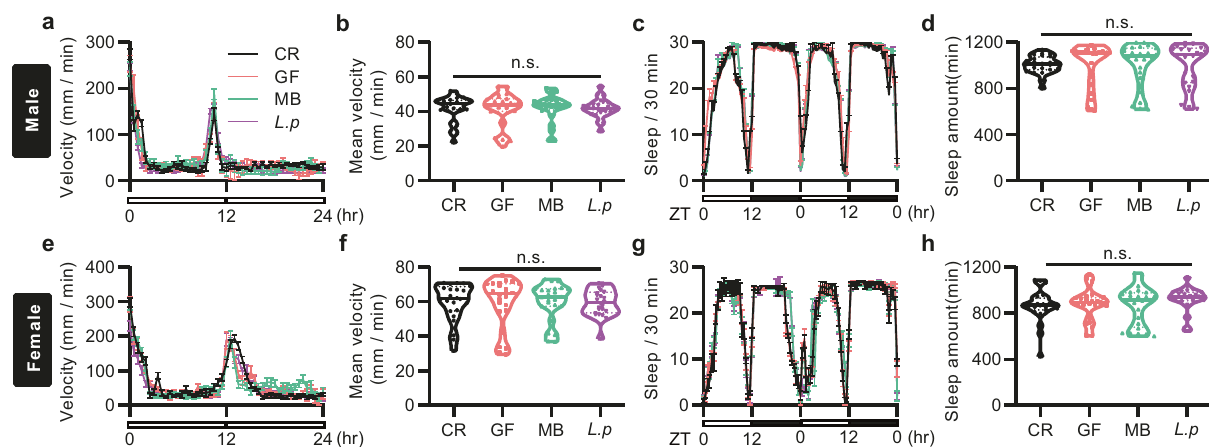
Fig. 2 Gut microbiome does not affect locomotor behaviors. a , b Drosophila 24-h walking speeds ( a ) and the average velocity ( b ) of GF males were not signi fi cantly different compared to CR, MB, and L.p counterparts. n = 24 for each. c , d GF males had largely unaltered sleep pro fi les ( c ) and total sleep amounts ( d ) in males compared to CR, MB, and L.p counterparts. n = 24 for each. e , f 24-h walking speeds ( e ) and the average velocity ( f ) of GF females were not signi fi cantly different compared to CR, MB, and L.p counterparts. n = 24 for each. g , h GF females had largely unaltered sleep pro fi les ( g ) and total sleep amounts ( h ) compared to CR, MB, and L.p counterparts. n = 24 for each. n.s. not signi fi cant. One-way ANOVA followed by Tukey ’ s multiple comparisons test. For a , c , e , and g , Error bars indicate